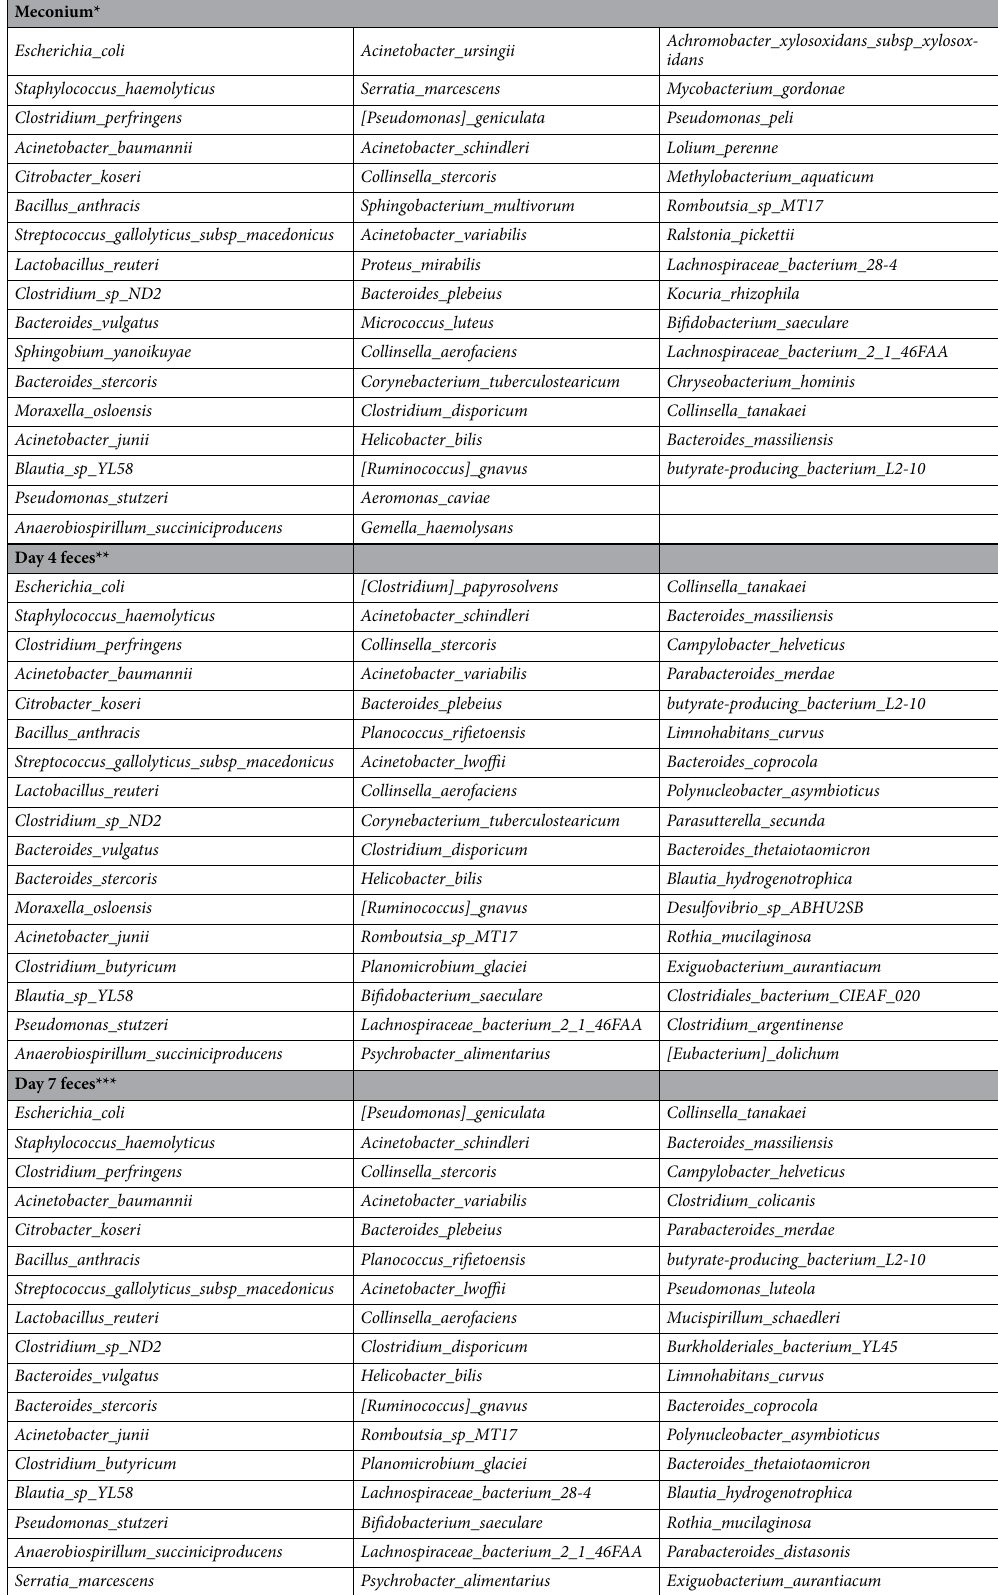
Table 2. 50 Highest OTU taxonomic annotations in species level of three time-point groups extracted from OTUs Taxonomy annotation list of species. *50 Highest OTU taxonomic annotations in species level